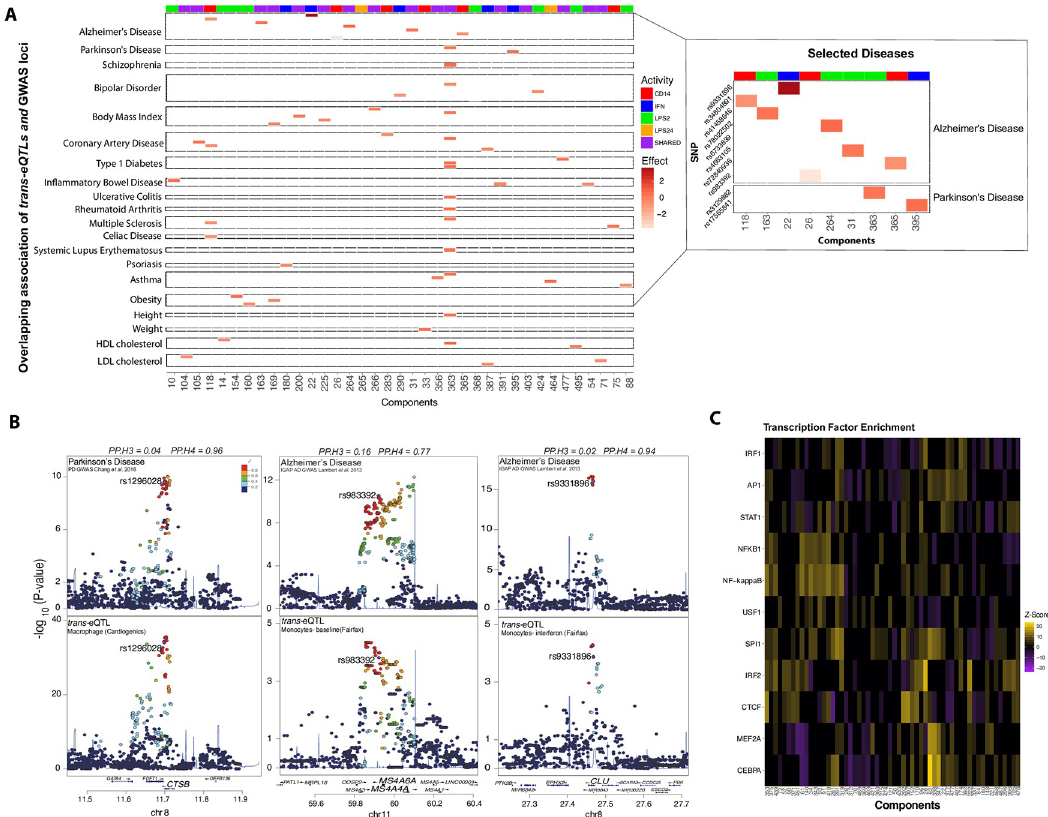
Fig 3. Trans -eQTLs colocalized in disease or trait-associated GWAS loci. (A) Significant trans -eQTLs in FF data (FDR < 0.15) in 20 selected disease or trait-associated GWAS loci (left panel). Shown are diseases-associated trans -eSNP on Y-axis and trans -eQTL components on X-axis. The red colored boxes reflect the effect size for the trans -eQTLs while the horizontal colored header reflects the condition activity scores. Trans -eQTLs that are in Alzheimer’s or Parkinson’s disease-associated loci (right panel). Alzheimer’s disease includes GWAS susceptibility loci from Alzheimer’s related traits including the age of onset, age-related cognitive decline, and APOE ε 4 carriers. (B) Colocalization of trans -eQTLs at Parkinson’s disease susceptibility locus CTSB (left panel) and Alzheimer’s disease-associated loci MS4A4A (middle panel) and CLU (right panel). The x-axis in each panel shows the physical position on the chromosome (Mb). The y-axis shows the -log 10 (P) association p-values for Parkinson’s disease [23–24] (left panel) and Alzheimer’s disease GWAS [20–22](middle and right panels). Listed on top are ‘coloc’ posterior probability for hypothesis 3 (PP.H3) and 4 (PP.H4). PP.H3: Association with eQTL and GWAS, two independent causal SNPs. PP.H4: Association with eQTL and GWAS, one shared SNP. (C) Transcription factors whose binding sites occurrence is enriched in the target set of genes within each sparse component compared to the expected occurrence estimated from a background